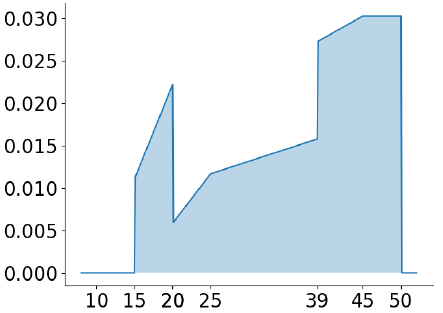
Figure 4. Product F X · f Y used for join selectivity